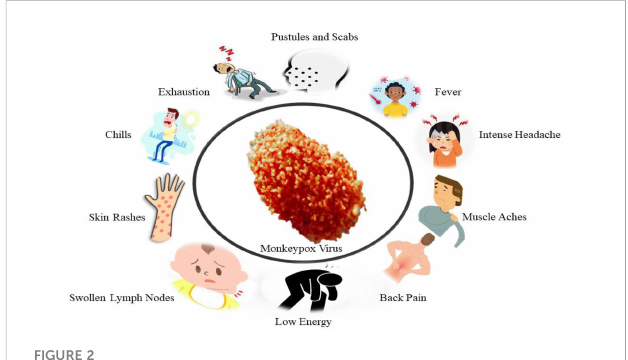
FIGURE 2 The sign and symptoms of MPX